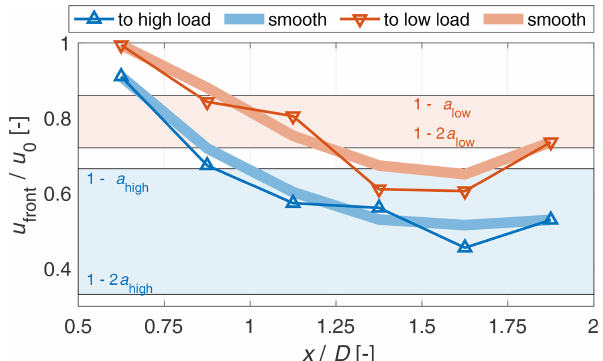
Figure 18. Velocity of the wake front for both pitch directions, nor- malised by the free wind velocity. For orientation, also the theo- retical normalised wind velocity in the rotor plane (1 − a ) and in the far wake (1 − 2 a ), based on the measured thrust coefficient, are indicated for both steady states.